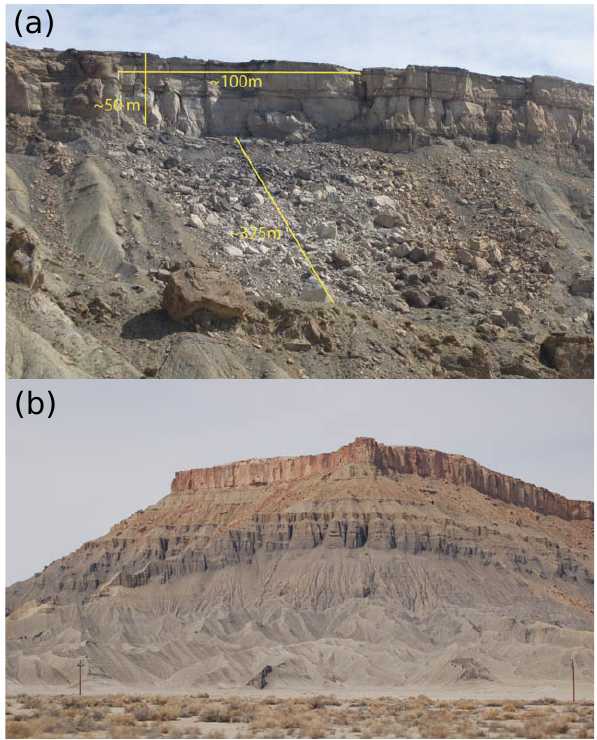
Figure 15. Two examples of cliff-and-rampart morphology. (a) Near Palisade, Colorado, USA, after recent rock-fall event (photo courtesy of D. Nathan Bradley and Dylan Ward). (b) Col- orado Plateau, Utah, USA. Note that contact between lower rampart and subvertical slopes, both of which have formed in a gray shale unit, occurs without any apparent break in lithology.